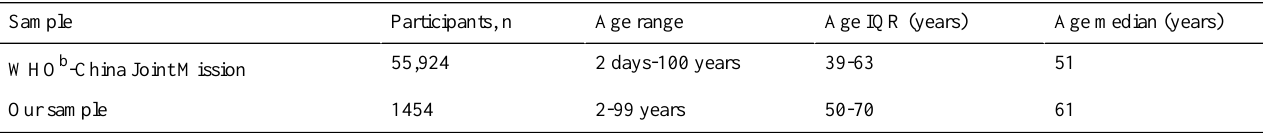
Table 1. Age comparison between our sample and that of the WHO-China Joint Mission.